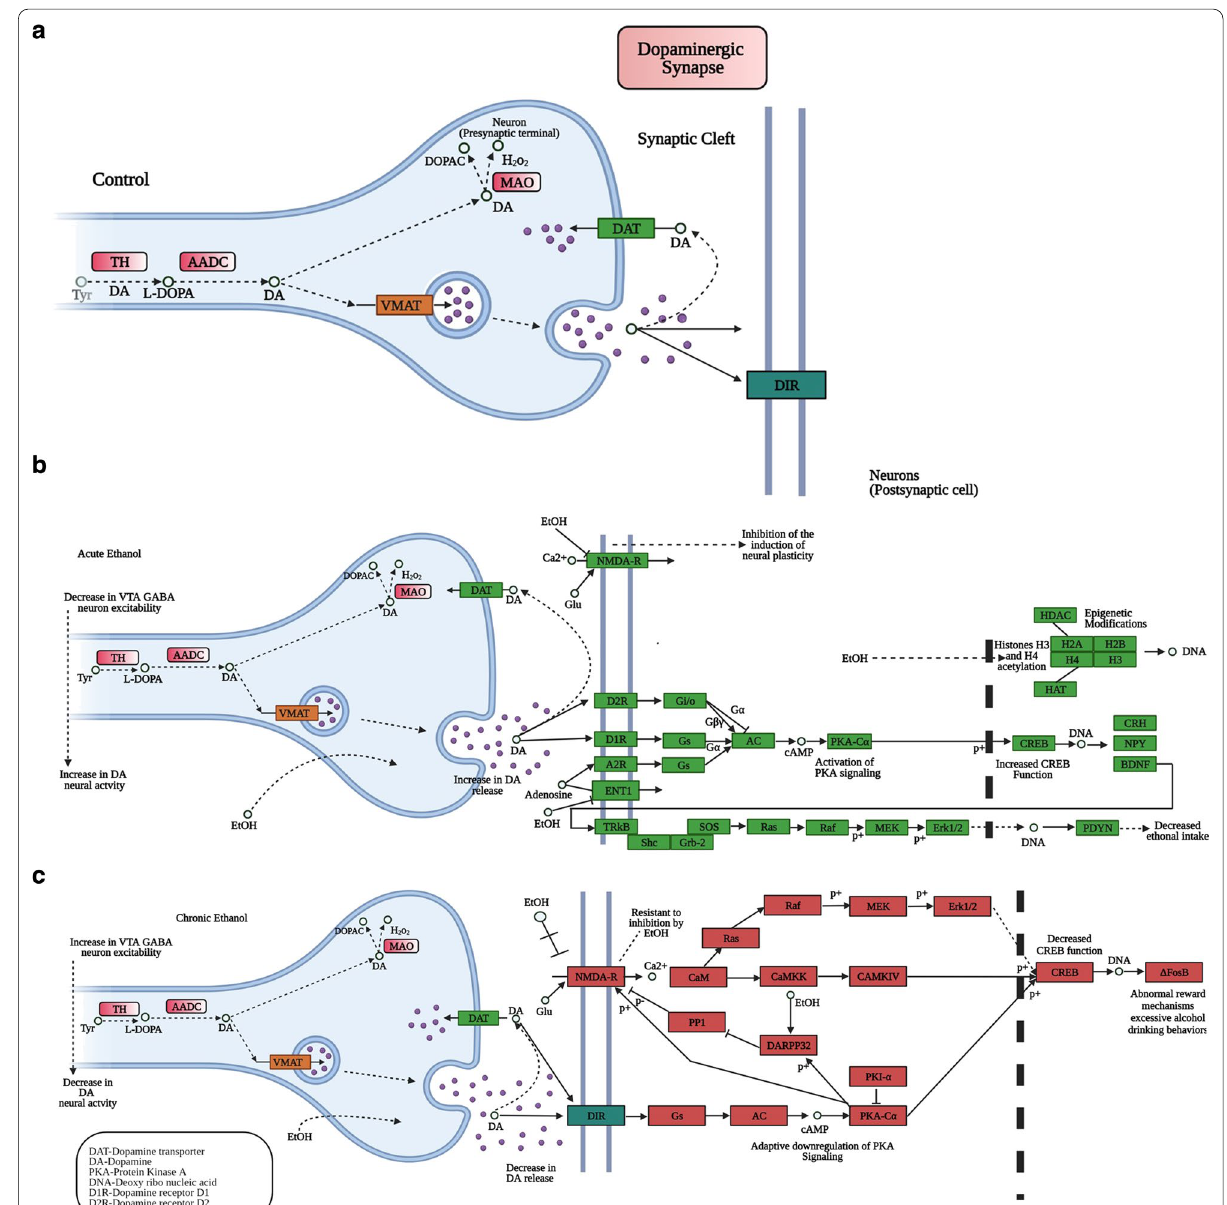
Fig. 3 Chronic amphetamine and its related signalling pathway: Ethanol also affects the production of Ca 2 + /calmodulin-dependent protein kinase IV (CaMKIV), a protein kinase whose major function is to activate CREB, resulting in CREB phosphorylation in the NAC. When D1 cAMP-PKA signalling is activated, not only CREB, but also DARPP-32, a 32-kDa protein produced mostly in synaptic neurons, is phosphorylated. Nicotine’s central effect is mediated by the nicotine acetylcholine nACh receptor. Vesicular GABA transmitter transports GABA neurons to synaptic vesicles in normal conditions (VGAT). GABA’s action is mediated via the GABAA receptor. Chloride ions channel (OCl2-), calcium ions channel (OCa 2 + ) and sodium ions channel (Na + ) are all present in the GABAA receptor in the postsynaptic